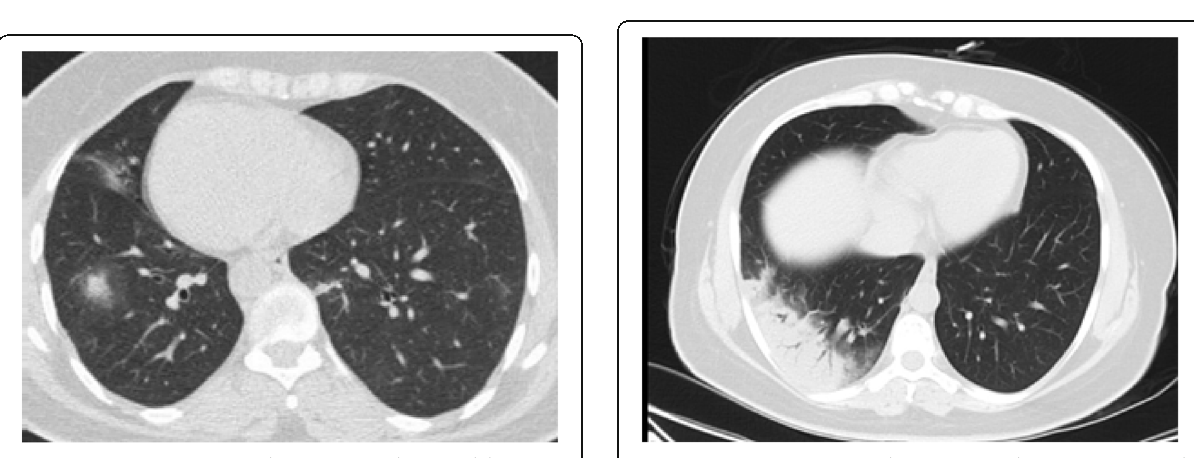
Fig. 17 COVID-19 pneumonia: thin section CT shows non segmental parenchymal consolidation with airbronchogram in right lower lobe.